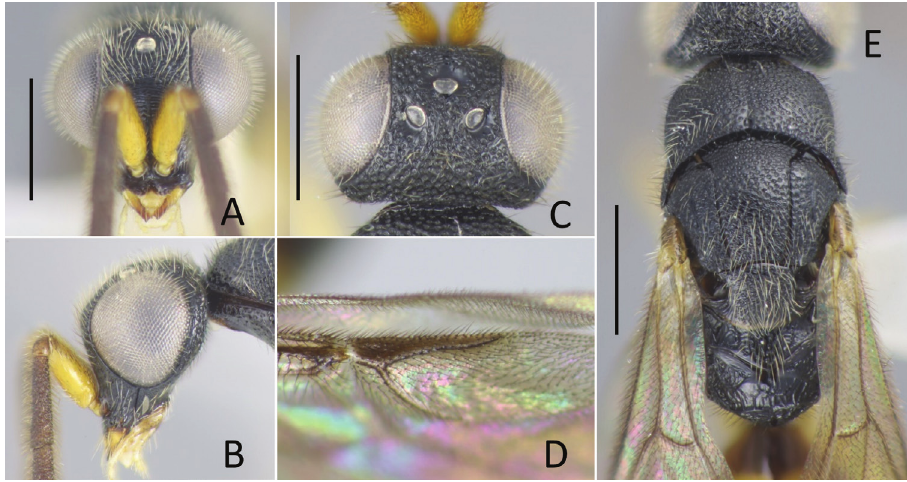
Figure 9. Nipponosega yamanei Kurzenko & Lelej ♂ A Head in frontal view B ditto, lateral view C ditto, dorsal view D forewing, pterostigma and R1 E mesosoma. Scale bars: 0.5